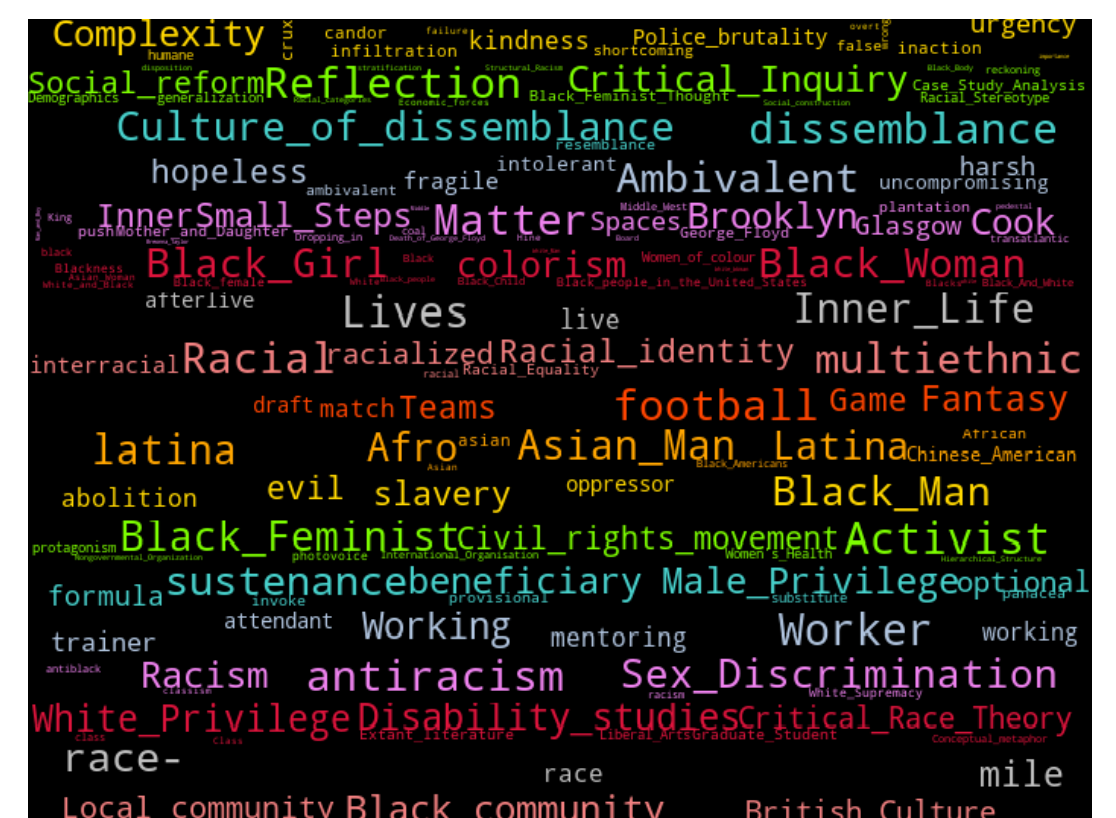
Figure 2. Stratified word cloud for one of the topic communities of the gender studies corpus. It can be interpreted as the topic race and gender